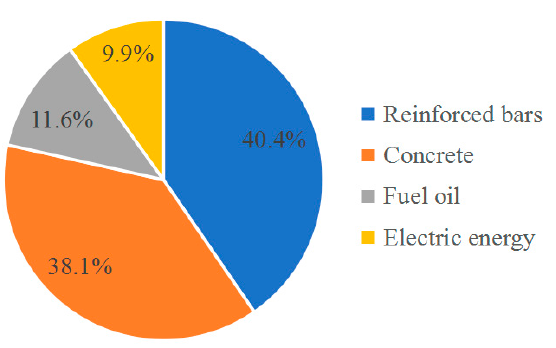
Figure 8. Proportion of carbon emissions generated by various materials and energy consumption of CG-2 composite beams during the production stage.